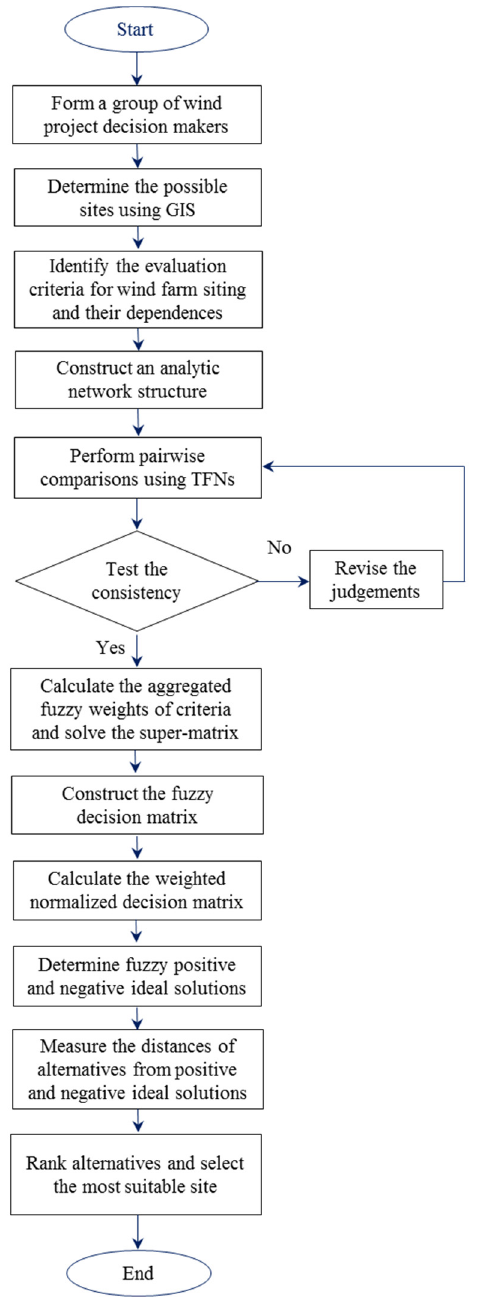
Figure 3. The proposed Fuzzy-ANP – TOPSIS methodology for wind farm site selection.